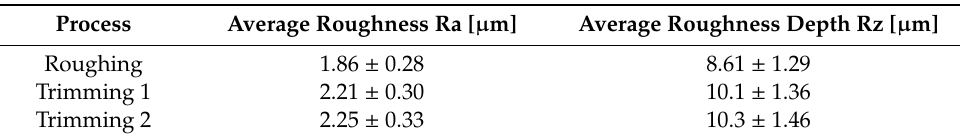
Figure 6. SEM images showing an overview of ZTA-TiN surfaces ED-machined with different parameter set.